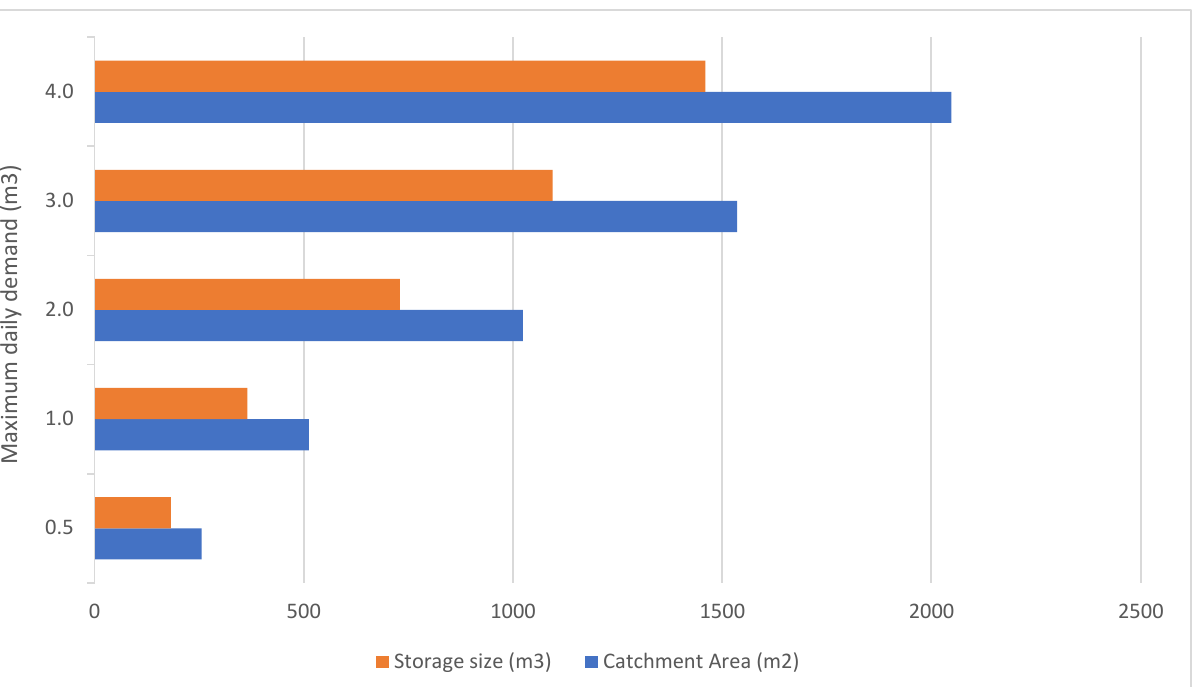
Figure 9. Illustration of water demand and resulting maximum catchment (m 2 ) and storage (m 3 ) sizes for securing the demand from roof catchments .